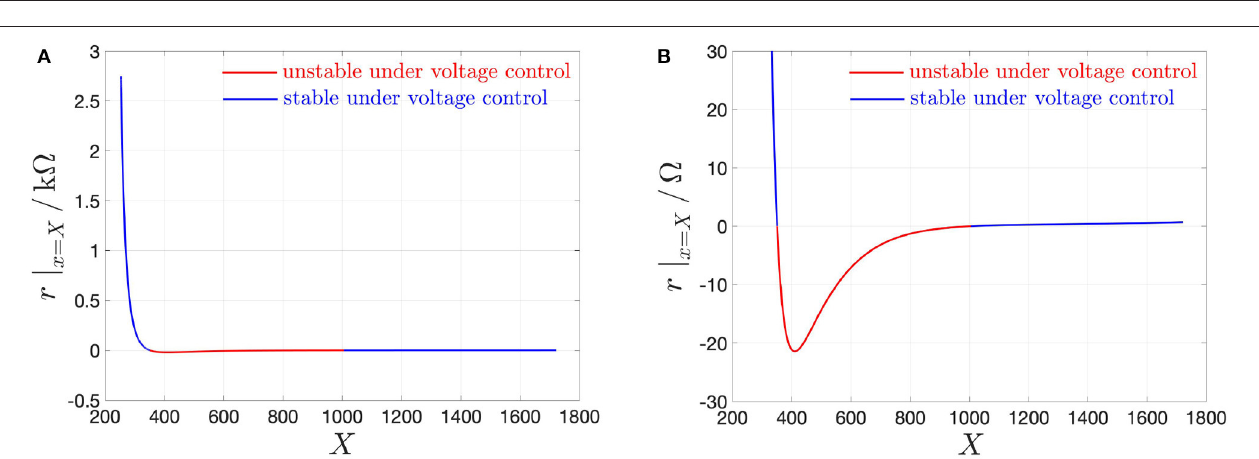
FIGURE 3 | (A) Small-signal resistance r the text, are associated to unstable (stable) memory state DC operating points for the voltage-driven memristor device. (B) Close-up view on the NDR region, identifiable on the horizontal axis for each X -value within the range [351,1006]. Note that small-signal resistance in the NDR region, appears at X X 478, where r is found to be equal to =